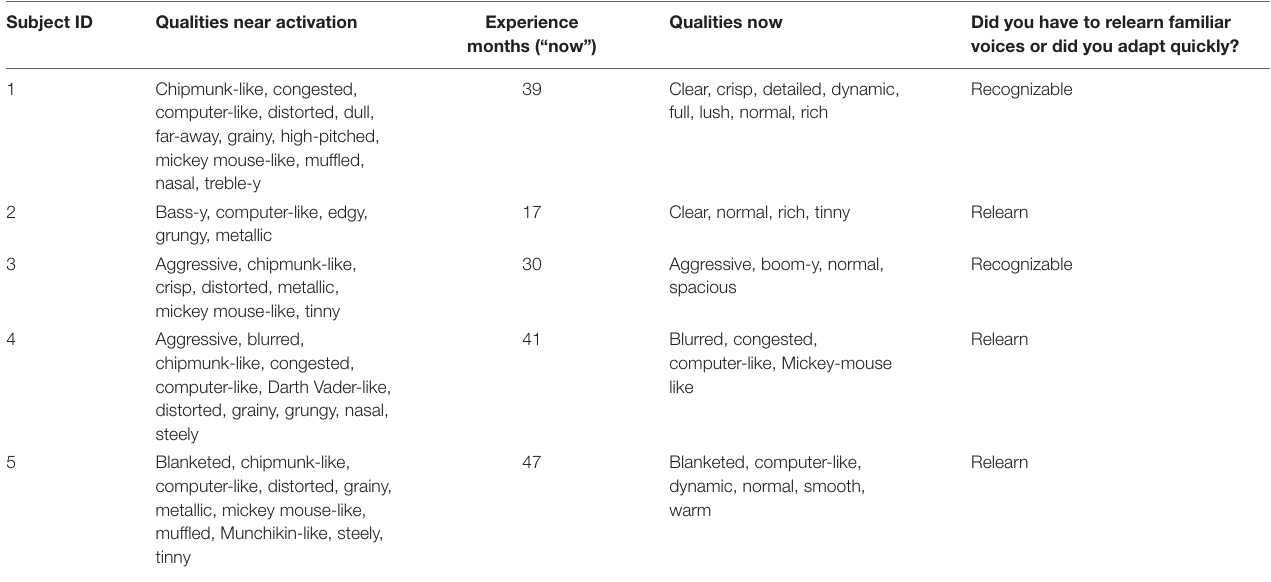
TABLE 3 | Descriptions of sound quality near time of activation and at Time